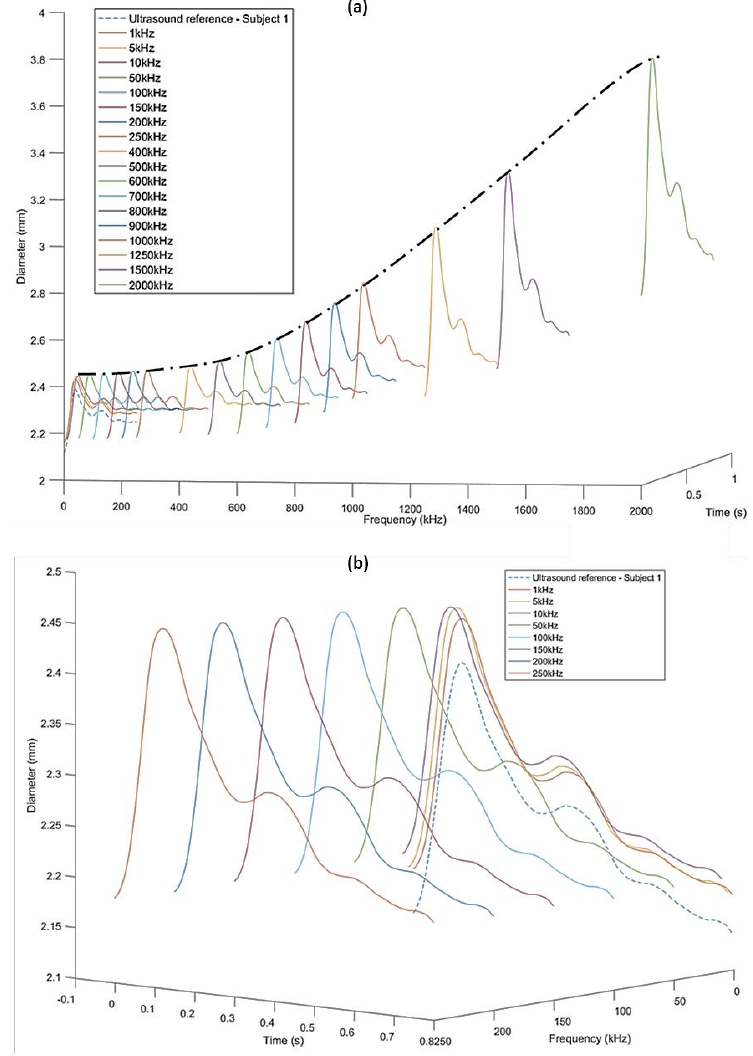
Figure 6. ( a ) Increasing trend of diameters obtained using simulation response for frequencies 1 kHz–2 MHz compared to the ultrasound-measured diameter for subject 1 (dashed line). ( b ) Simulation- obtained diameters within 1–250 kHz with the same magnitude and in constant proportion with the reference ultrasound-measured diameter (dashed line).